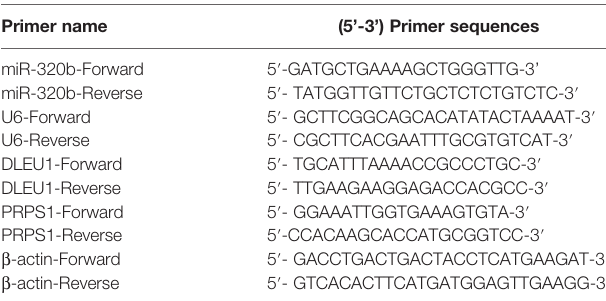
TABLE 1 | Primer sequences for